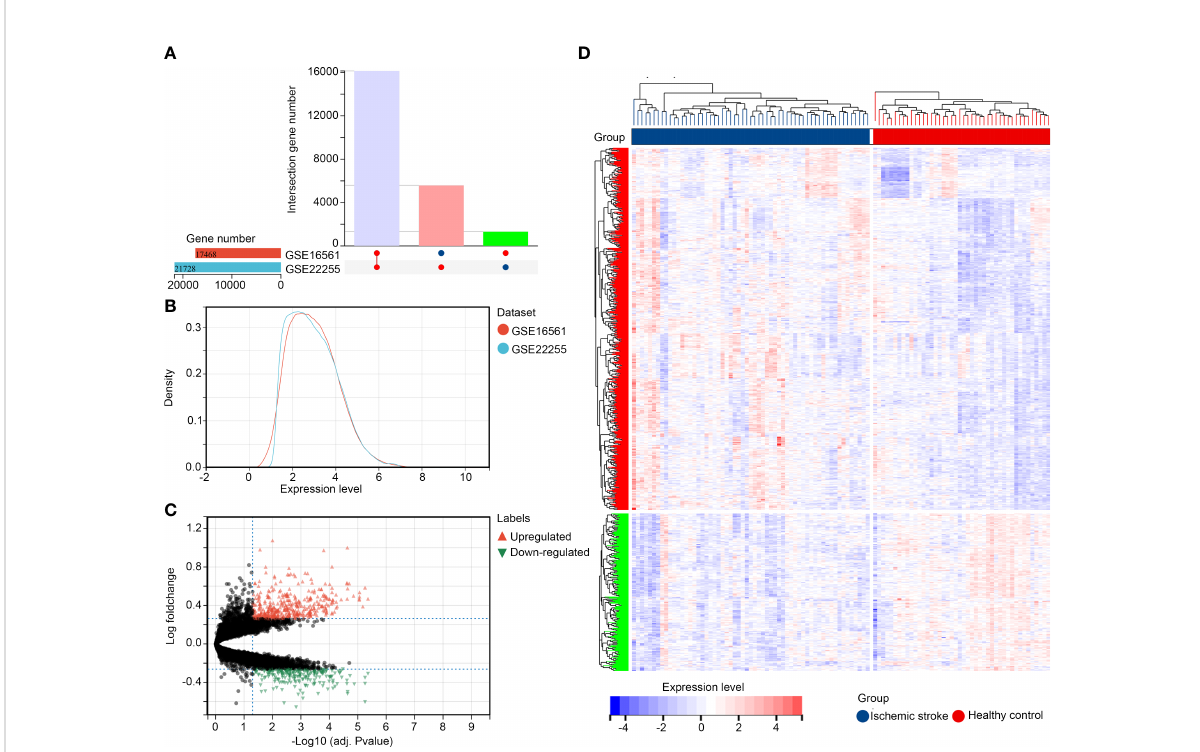
FIGURE 1 Identi fi cation of DEGs in IS (A, B) Merged and normalized gene expression pro fi les of GSE22255 and GSE16561 datasets; (C, D) Identi fi cation of DEGs between healthy controls and patients with